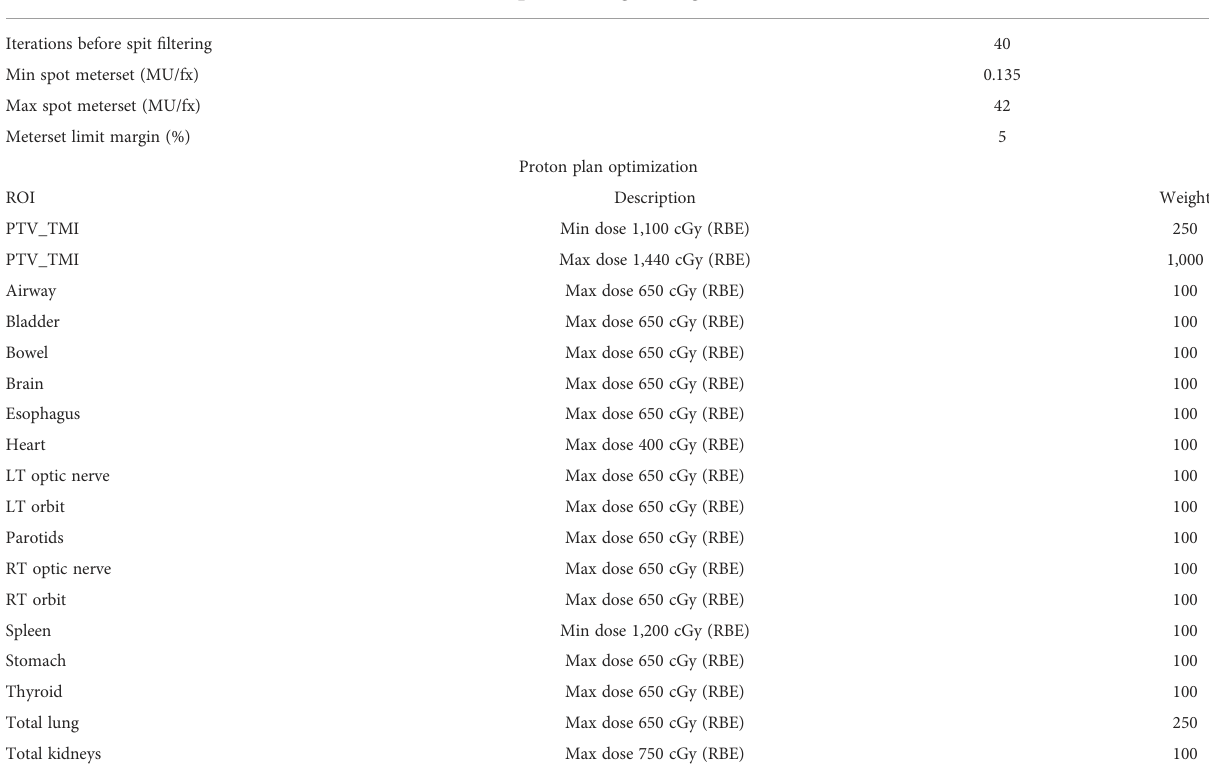
TABLE 2 Settings of dose parameters used for proton optimization and